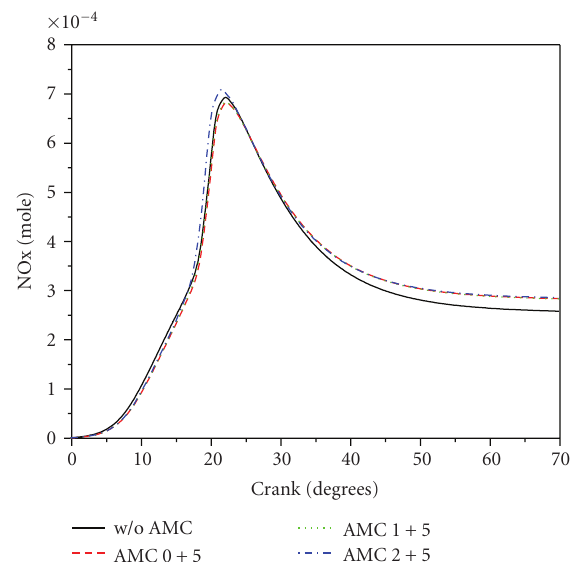
at CA = 3 and 18 deg ATDC. Figure 8 shows iso-surface of the flame front on the same cut plane with contour plot of NOx at CA = 18 deg ATDC. Autoignition